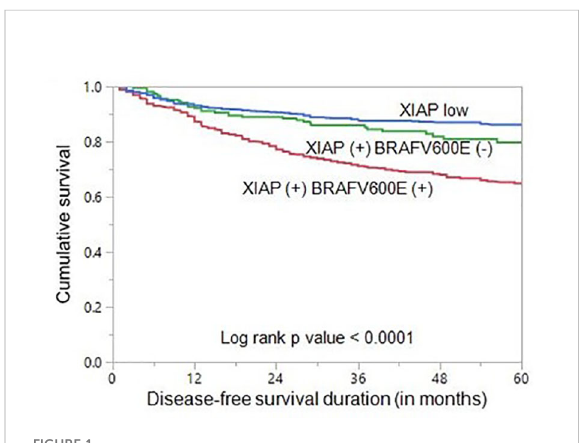
FIGURE 1 Disease-free survival (DFS) in papillary thyroid carcinoma (PTC). Kaplan-Meier survival curve showing shorter DFS in patients with co-existing XIAP over-expression and BRAF mutation compared to those with co-existing XIAP over-expression and BRAF wildtype or XIAP low expression groups (p <